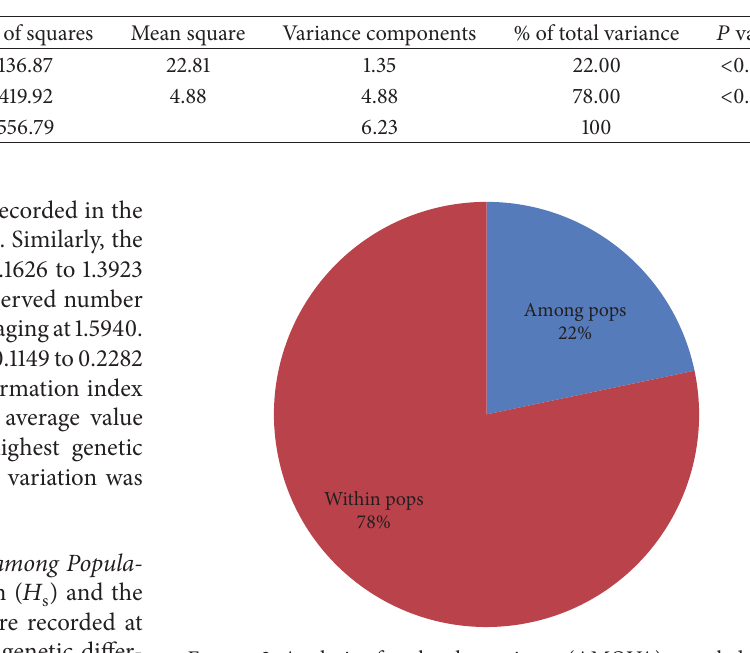
Figure 2: Analysis of molecular variance (AMOVA) revealed 22% of the genetic variation existing among populations and 78% within the populations.